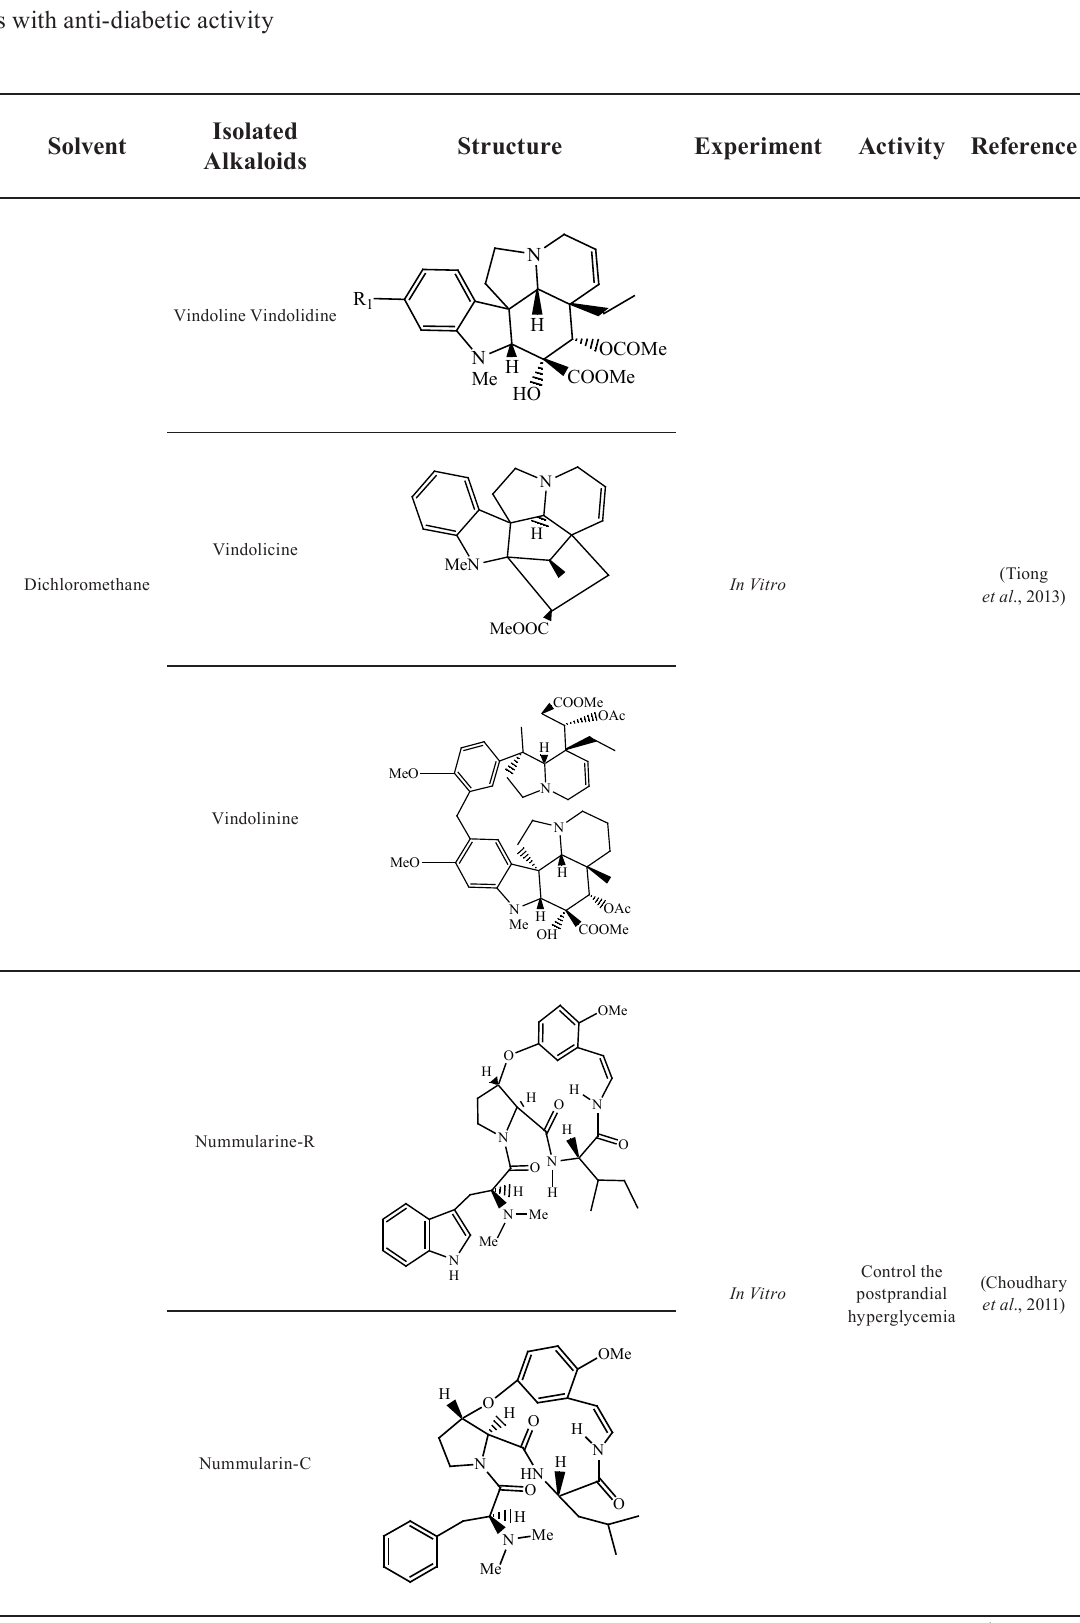
TABLE I – A lkaloids with anti-diabetic activity